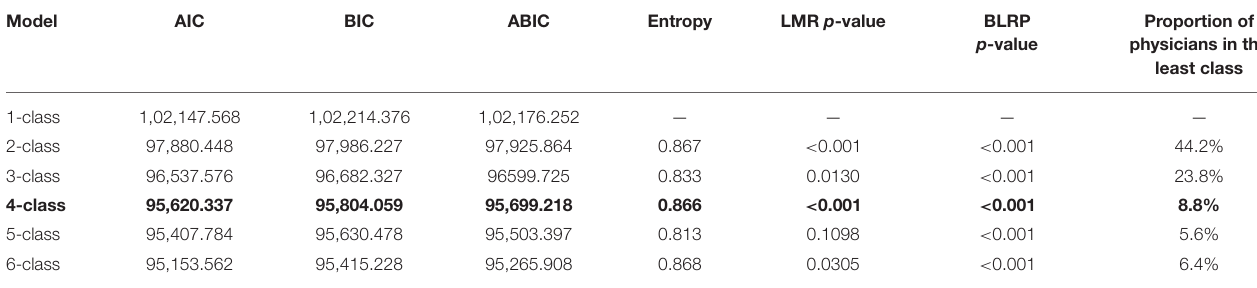
TABLE 2 | Latent profile analysis models and fit indices.